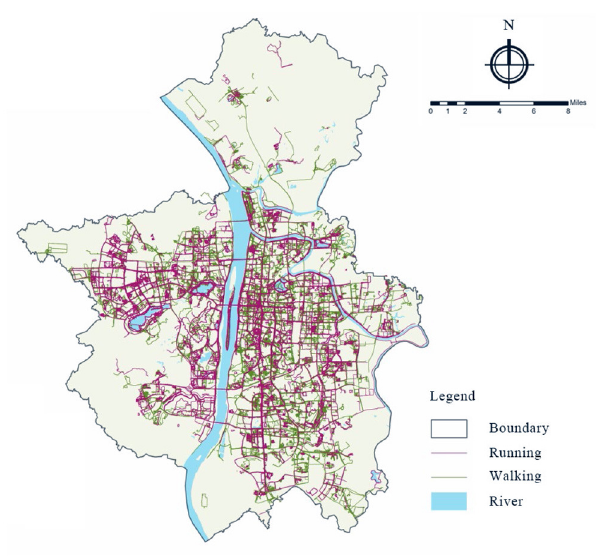
FIGURE 1 | Distribution of slow motion physical activity trajectories (pink for running, green for walking).